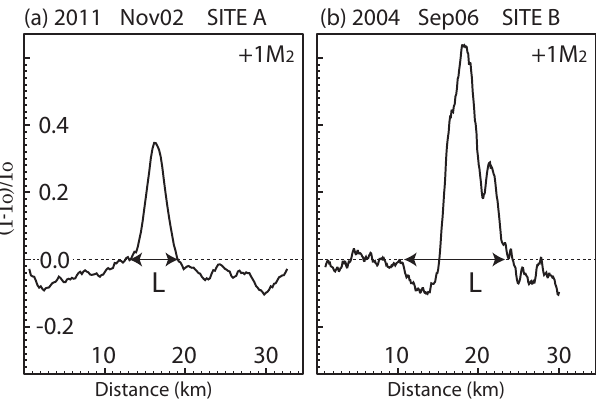
Figure 4. Normalized backscatter intensity profiles corresponding to representative wave packets in Fig. 3a (left panel) and b (right panel). See Fig. 3b for a representative radar backscatter transect (used to compute I) and corresponding mean unperturbed back- ground (used to compute I 0 ) . A measure of the waves’ horizontal dimensions is given in both panels (i.e. L ; see text for more details).